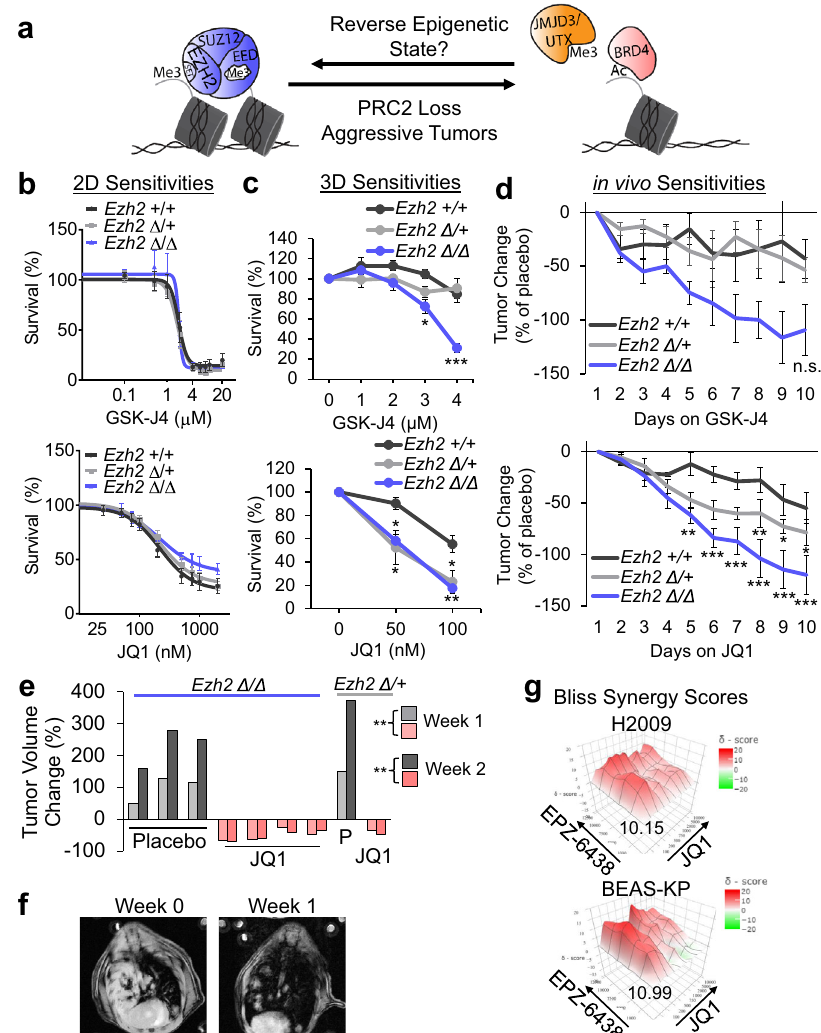
Fig. 6 | Polycomb de fi ciency drives BET and JMJD3/UTX inhibitor sensitivity. a Schematic depicting the mechanisms to restore epigenetic states lost in PRC2- de fi cient tumors. b , c GSK-J4 (upper) and JQ1 (lower)percentage survival of ( b ) 2D cultures after 4 days culture with drugs plotted as mean values +/ − SEM. GSK-J4: n =7, 7, 7; JQ1; n =5, 6, 5 for Ezh2 WT, heterozygous, null individual mouse tumor- derived cultures, respectively. c 3D tumoroids after 12 – 14 days culture with drugs plottedasmeanvalues+/ − SEM.GSK-J4:*indicates P =0.0158 Ezh2 WTvs. Ezh2 null, *** P =0.0006 Ezh2 WT or heterozygous vs. Ezh2 null; JQ1: * indicates P <0.039 and ** P =0.0084for Ezh2 WTvs. Ezh2 null(lower)or Ezh2 WTvs.heterozygous(upper) byone-wayANOVAwithmultiplecomparisonsandHolm- Š ídák ’ sposthoc.Forboth drugs, n =7, 5, 5 for Ezh2 WT, heterozygous, null individual mouse tumor-derived cultures, respectively. d Changes in volumes of grafts in mice treated with GSK-J4 and JQ1 relative to changes in placebo-treated mice plotted over time as mean values +/ − SEM. *** indicates P <0.0008, ** P <0.0091, * P <0.0472 for Ezh2 WT vs.